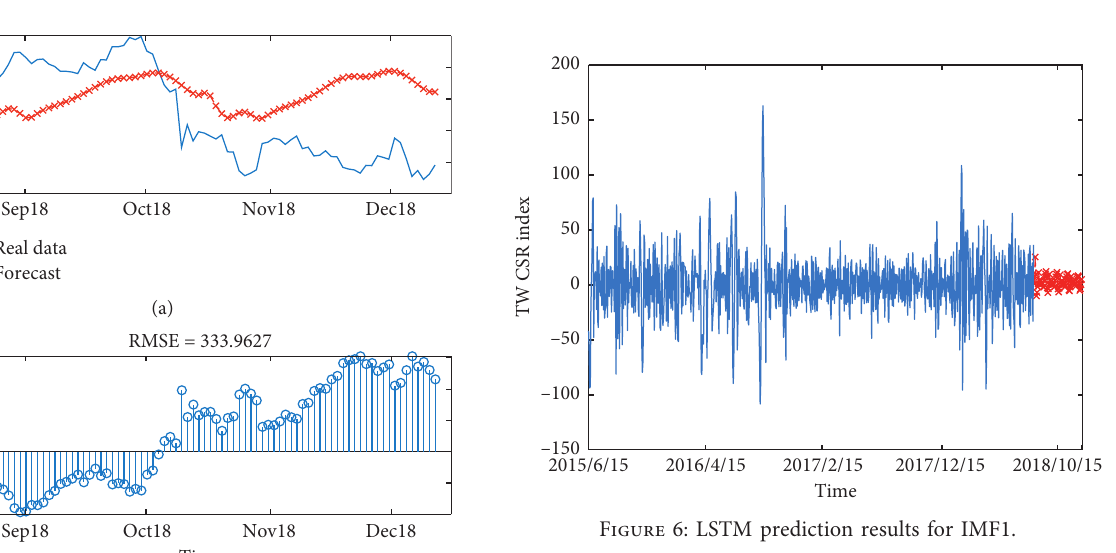
Figure 5: EMD analysis of the Taiwan CSR index used to get IMF1.